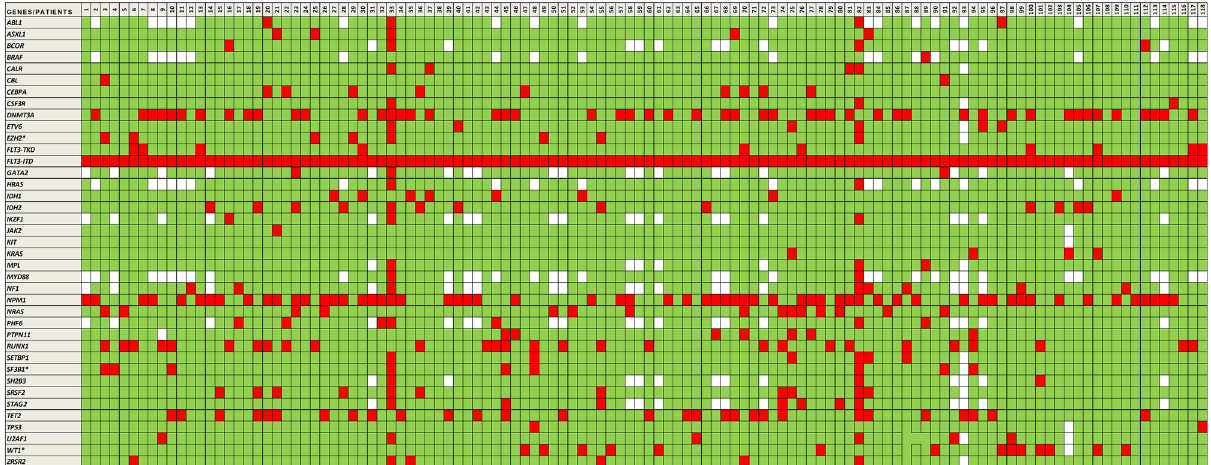
Figure 4. The landscape of mutations identified by NGS in AML patients. These mutations arearranged in increasing order by FLT3 -ITD length. Green indicates non-mutated genes, red indicates mutated genes and white indicates non-mutated genes. * Genes with a P value < 0.05 in the Mann–Whitney test correlating mutational status with ITD